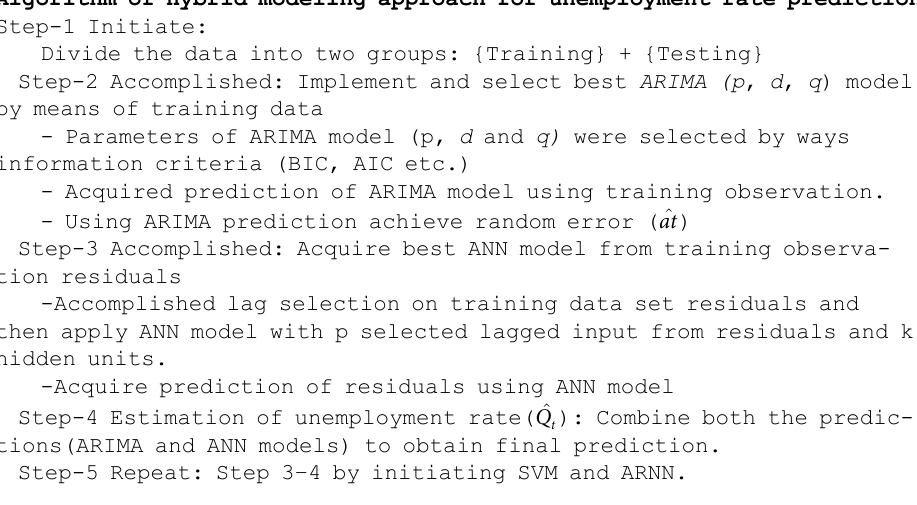
Algorithm of Hybrid modeling approach for unemployment rate